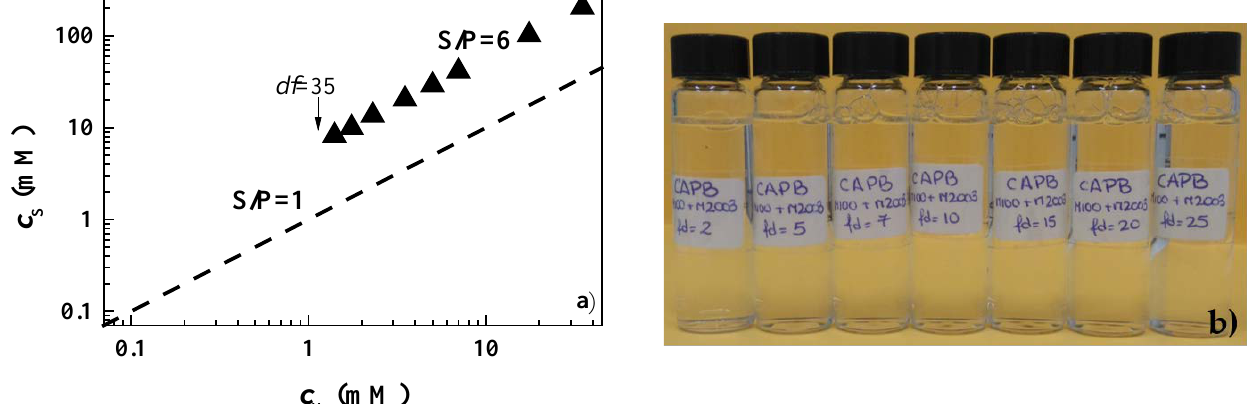
Figure 11. ( a ) Surfactant–polymer concentration phase diagrams for the combination of PDADMAC, Merquat 2003, and CAPB. The symbols correspond to one-phase mixtures and the discontinuous solid line corresponds to the dilution of a hypothetical mixture with S/P = 1. The value of the dilution factors ( df ) corresponding to the maximum df explored is also indicated. Furthermore, the S/P value corresponding to the dilution line of the sample is also included. Notice that polymer concentration is referring to the total concentration of cationic monomers, including those corresponding to both polymers. ( b ) Image showing the dilution process (from left to right) of the pseudo-ternary polymer–CAPB mixtures with the same composition of components as in Table 2.